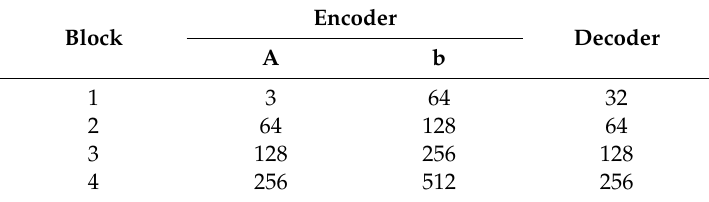
Table 2. The receptive field (rf) and stride size (s_size) in encoder module used in ECNet.